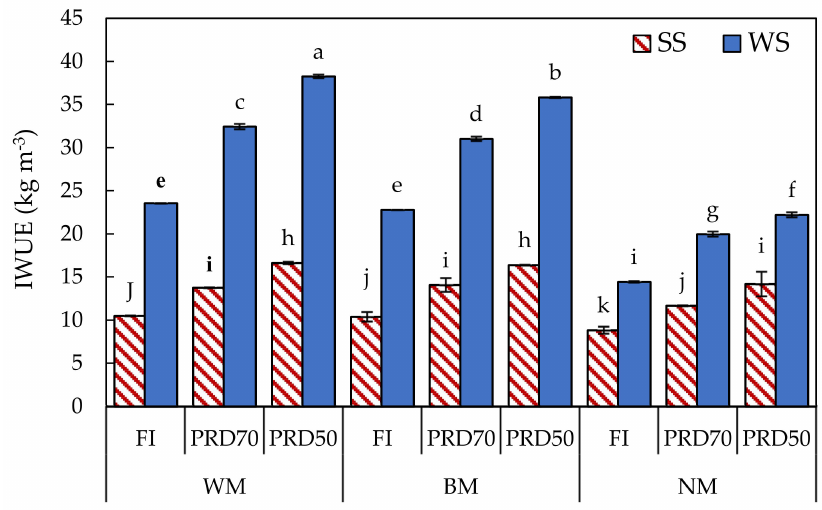
Figure 7. Squash irrigation water use efficiency (IWUE) during winter (WS) and spring (SS) under mulch treatments (black mulch-BM, transparent mulch-WM and non-mulch- NM) and irrigation treatments (full irrigation-FI, partial root drying with 50% of evapotranspiration- PRD50, partial root drying with 70% of evapotranspiration-PRD70); the data is the mean value ± standard error; different letters indicate significant difference between